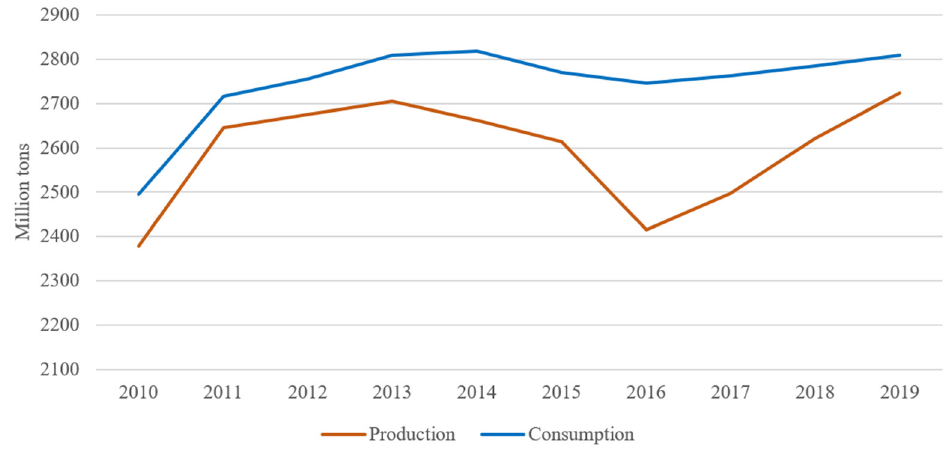
Figure 1. Coal production and consumption of China (2010–2019). Data source: National Bureau of Statistics of China.